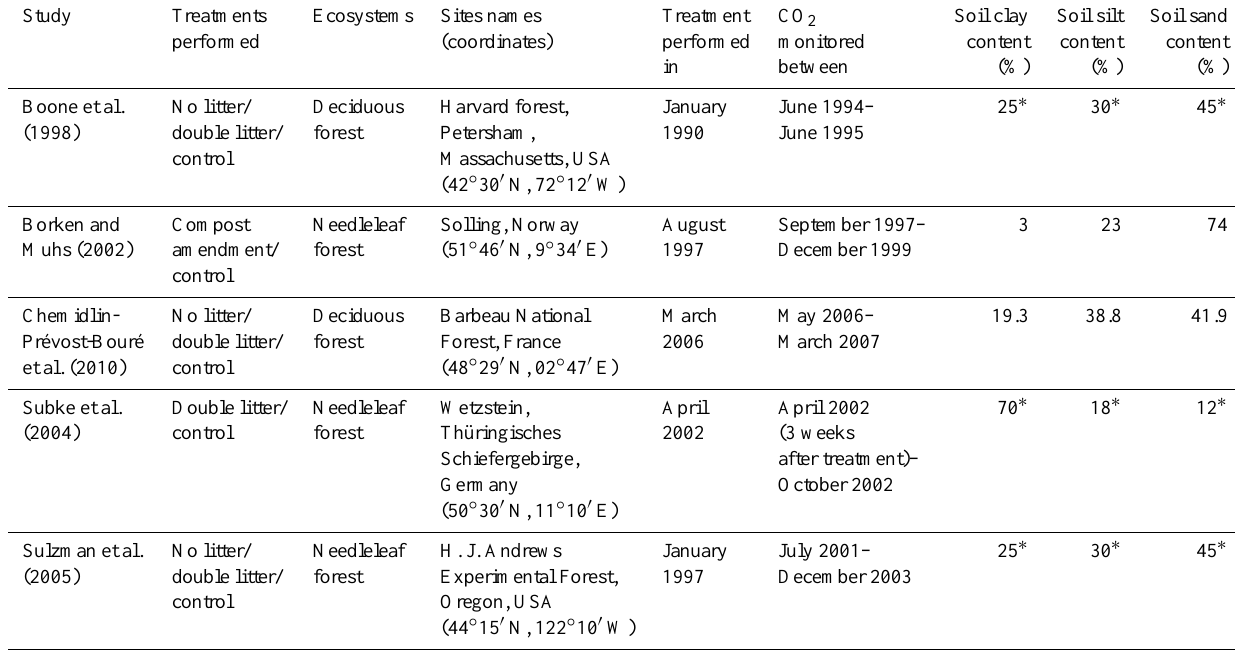
Table 3. Description of the studies used to evaluate the model.